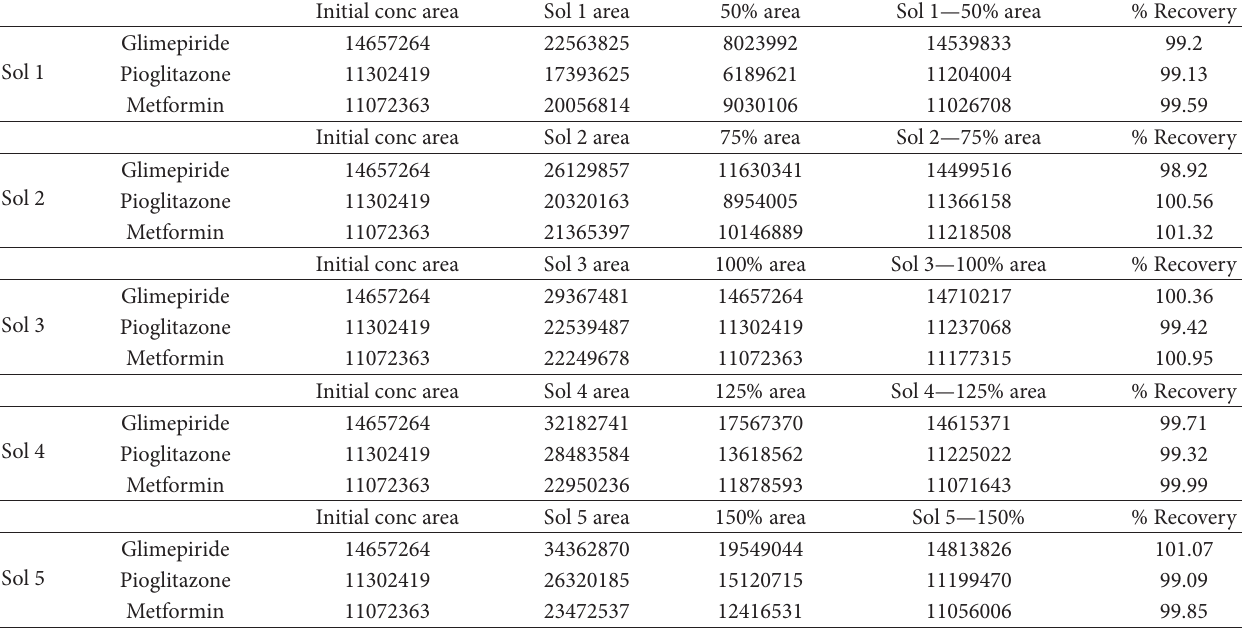
T 3: Results for accuracy of the method.